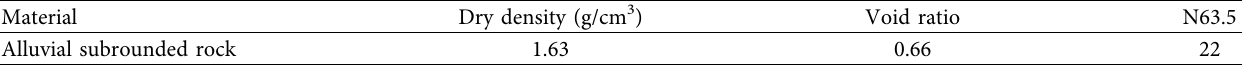
Table 10: Rockfll characteristics.